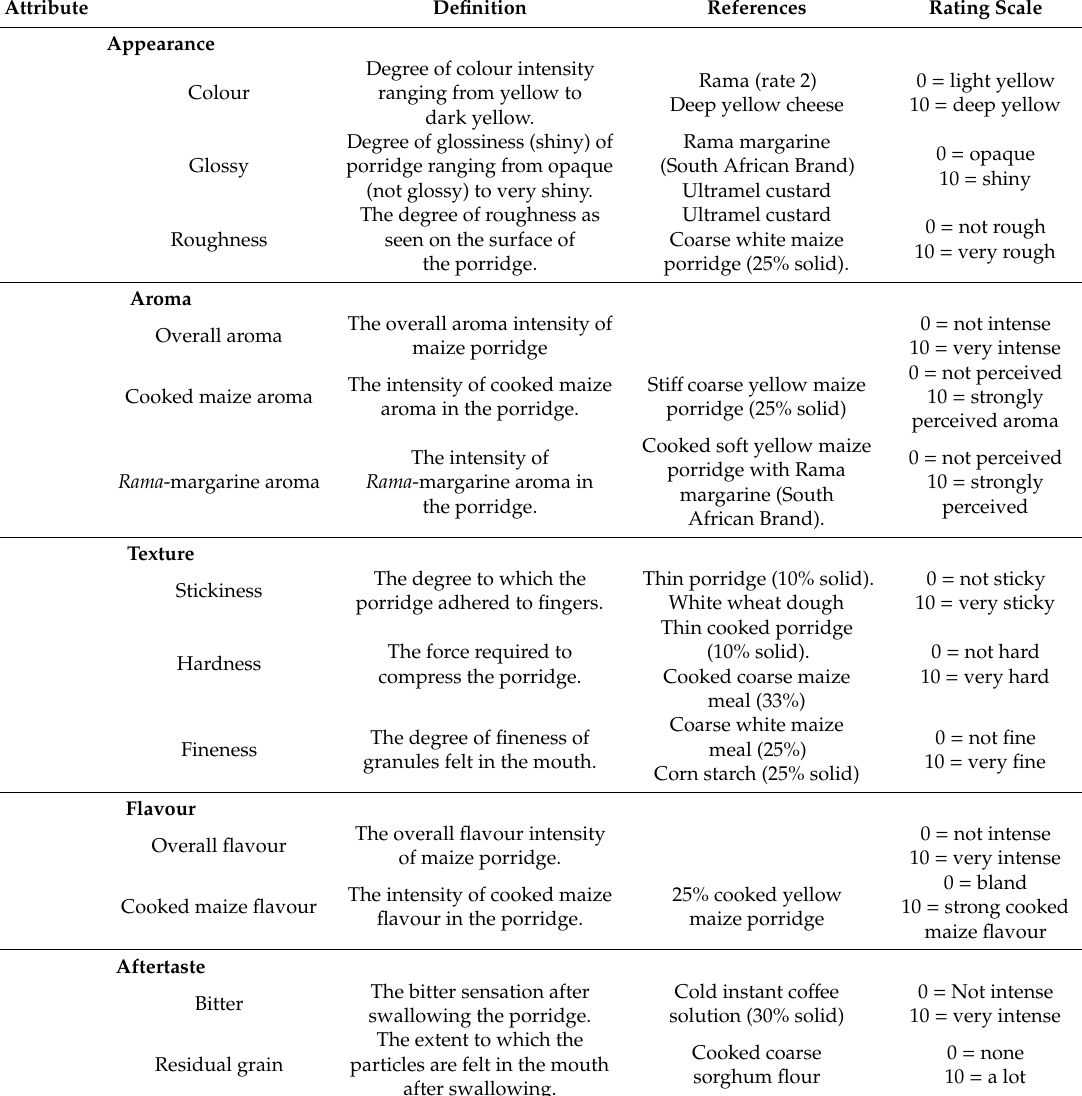
Table 1. Descriptors developed by the trained sensory evaluation panel for the profiling of the provitamin A-biofortified maize sti ff porridges and the representative white